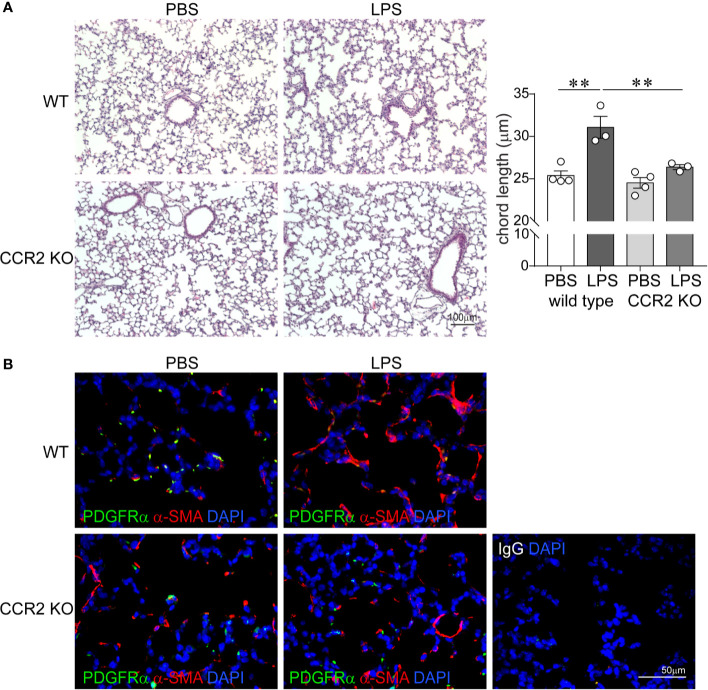
CCR2 deficiency attenuates repetitive LPS-induced hypoalveolarization and restores normal pattern of α-smooth muscle actin and PDGFR-α expression in the distal lung. Immature wild type and CCR2−/− mice were inoculated with LPS or PBS intranasally on days of life 3, 5, 7, and 10. Lung histology was assessed on day of life 14. (A) Representative lung sections were stained with hematoxylin and eosin. Unlike wild type mice, LPS-exposed CCR2−/− mice do not develop increased alveolar size indicative of alveolar simplification. After LPS exposure, the chord lengths of CCR2−/− mice were significantly lower compared to wild type mice. N = 3–4 per group, mean ± SEM, **different from PBS-exposed group, **P < 0.01. (B) Lung sections were stained for α-smooth muscle actin (red) and PDGFR-α (green). In wild type, PBS-treated mice, α-smooth muscle actin (red) and PDGFR-α (green) were predominantly at the tips of secondary crests. In contrast the wild type, LPS-exposed lung has abnormal α-smooth muscle actin (red) widespread throughout the interstitium, and there are very few PDGFR-α (green)-positive cells at the tips of secondary crests. In LPS-exposed CCL2−/− lungs α-smooth muscle actin (red) and PDGFR-α (green) were predominantly at the tips of secondary crests, a pattern similar to wild type mice. The representative images are from a random coronal section. The experiments were repeated two times with similar results.